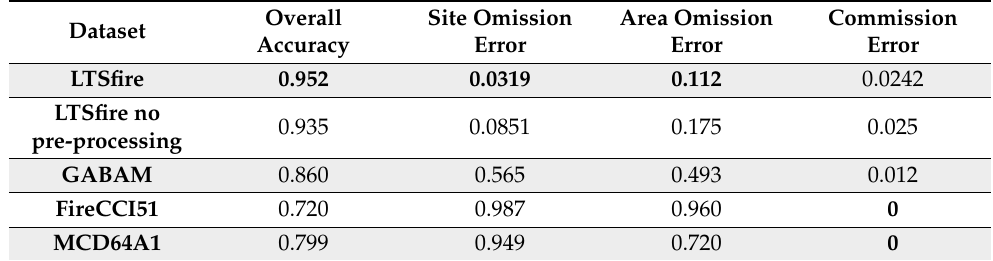
Table 1. Accuracies of LTS fire and existing global burn-area products. The burn-area maps were compared with 94 known burn-area polygons and 173 unburnt polygons. Site omission errors refer to the proportion of undetected burn-area polygons (no overlap at all); area omission errors refer to the proportion of burnt area omitted; commission errors refer to the proportion of unburnt area misclassified as burnt; and the overall accuracy refers to the overall proportion of correctly classified area. Numbers representing the highest accuracy or lowest error is